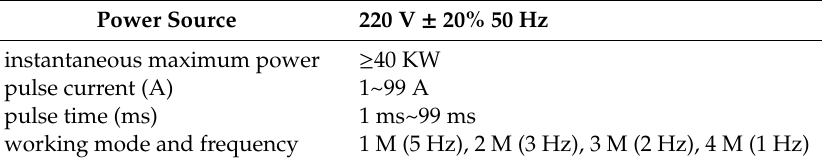
Figure 4. Residual stress testing. Table 5. Parameters and indicators of the JYPSD-2 welding machine.